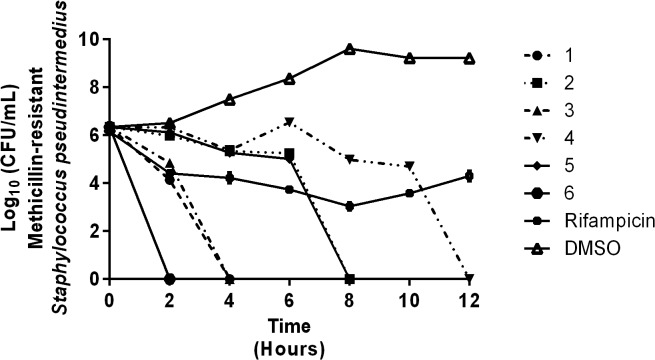
Time-kill analysis of thiazole compounds and rifampicin against methicillin-resistant Staphylococcus pseudintermedius SP3.Bacteria were incubated with 4 × MIC (in triplicate) of thiazole compounds or rifampicin over a 24 hour incubation period at 37°C. Samples were collected at 0, 2, 4, 6, 8, 10, 12, and 24 hours. DMSO served as a control. The error bars represent standard deviation values obtained from triplicate samples used for each compound studied.